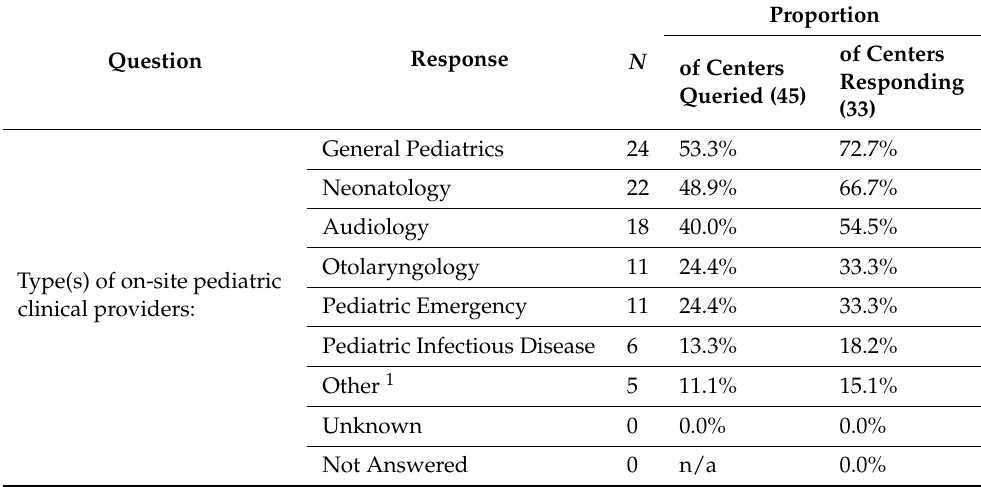
Table 1. Responses to demographic questions.